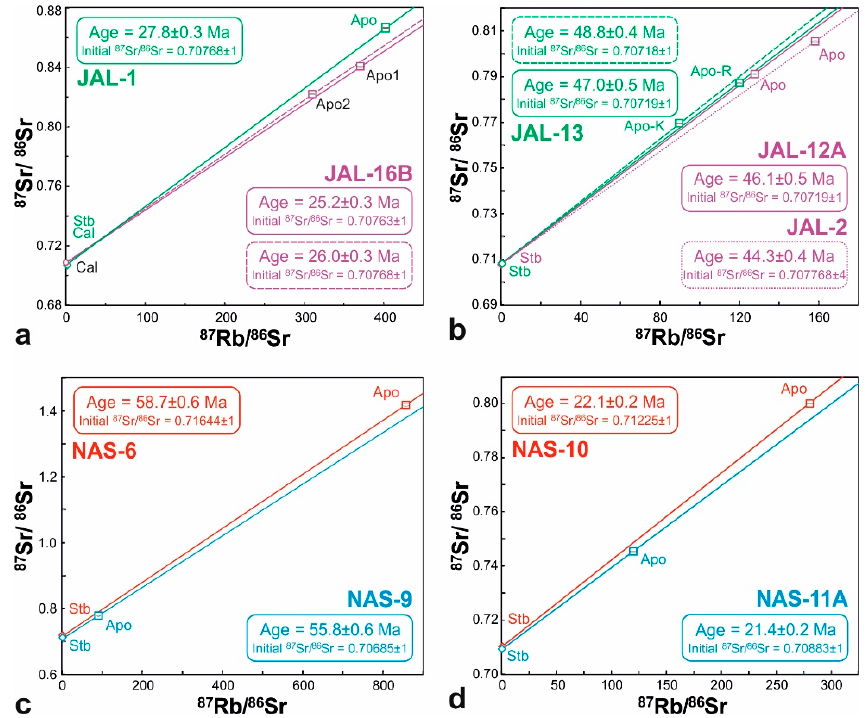
Figure 16. Rb ‐ Sr age data of apophyllites sampled at different localities. Data from the western ( a ) and eastern ( b ) part of the Savda quarry complex; Paleogene ( c ) and early Miocene ( d ) ages from the Nashik area. Table 9. Rb ‐ Sr isotopic data on whole rock (WR), calcite (Cal), stilbite (Stb), apophyllite (Apo), and celadonite (Cel) from Savda and Nashik (DVP, India). Rb ‐ Sr ages are calculated from apophyllite and corresponding calcite, stilbite, or whole rock, assuming an error of ±1% on the 87 Rb/ 86 Sr ratio.